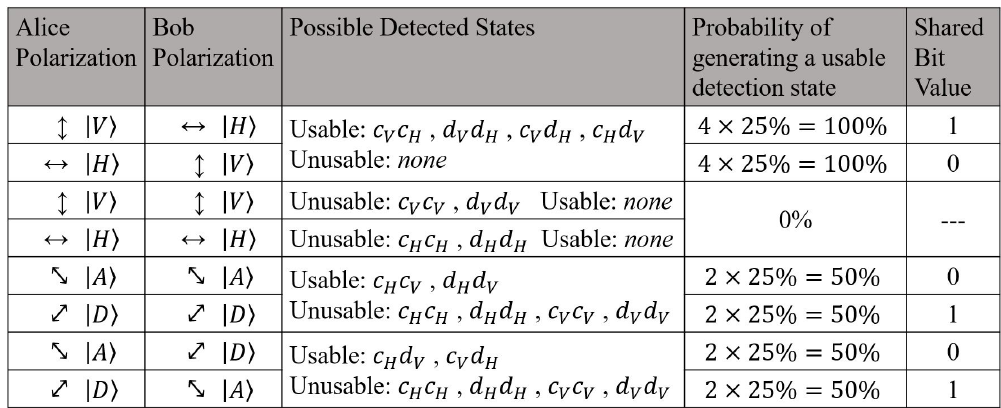
Figure 2. Representative sequences of events for the MDI-QKD protocol for two particular input states. Table 1. Nominal probability of generating a key bit and the shared secret bit value for all eight same-basis photon polarization encodings and associated measurement